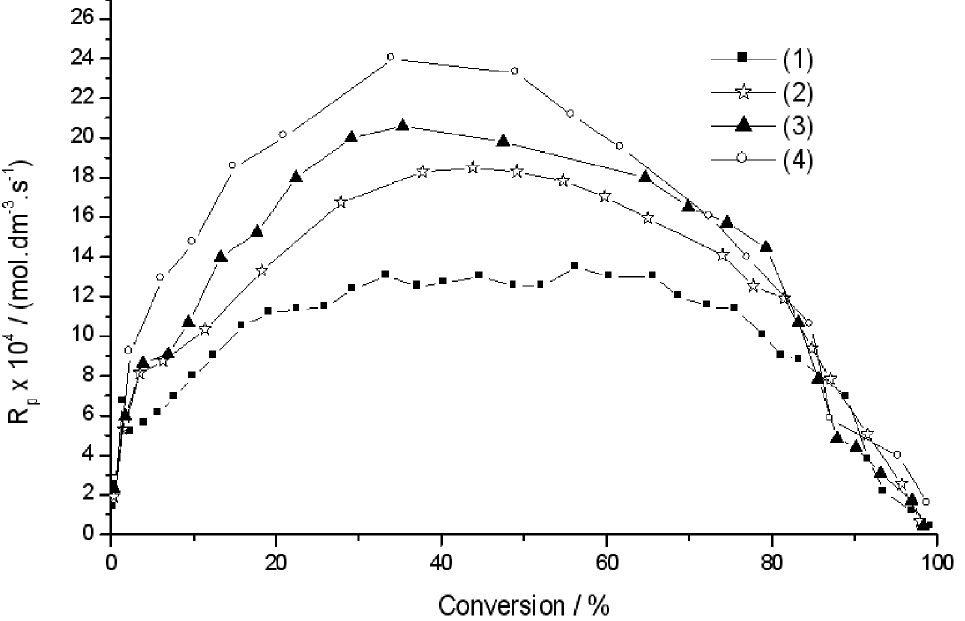
Fig. 5 Variation of the rate of polymerization in the inverse miniemulsion copolymerization of AAm and MA with MBA concentration and conversion. Recipe: 100 g cyclohexane, 35 g water,